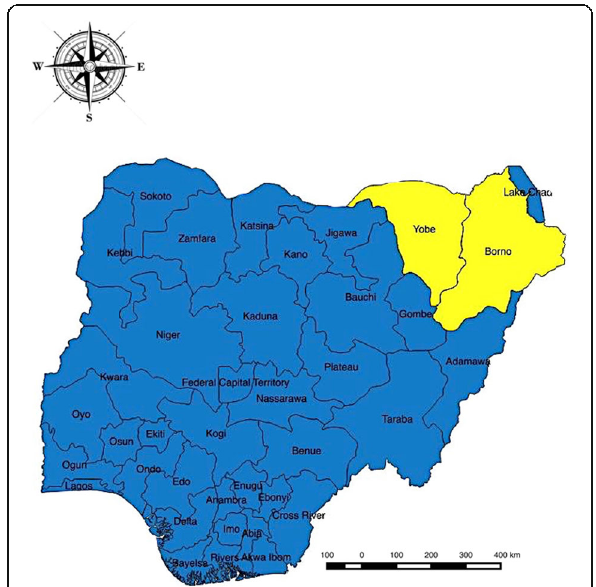
Figure 1 Map of Nigeria showing Borno and Yobe States, Northeastern Nigeria (study